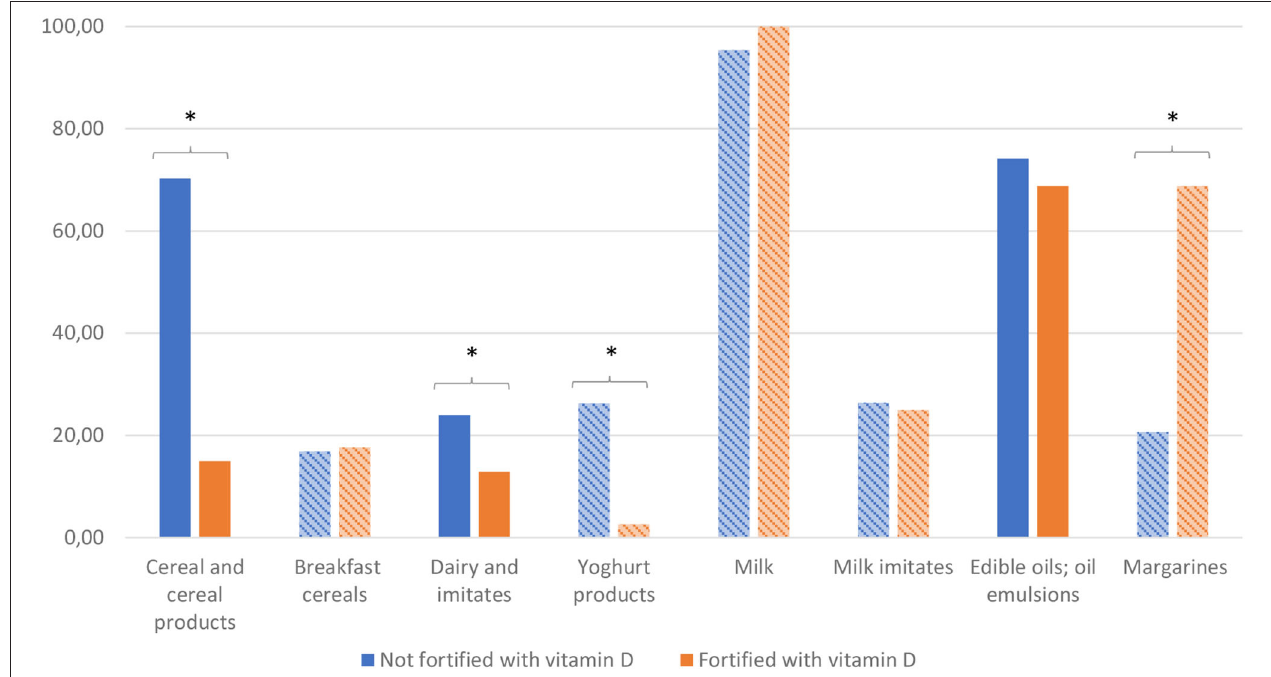
FIGURE 2 | (Sub)category proportions (%) of (healthier) foods passing WHOE nutrient profile model for samples of foods (1) which are not fortified, or (2) are fortified with vitamin D. *Significant differences. Subcategories are shown in bars using diagonal lines pattern. Profiling using the WHO Europe (WHOE) nutrient profile (62).